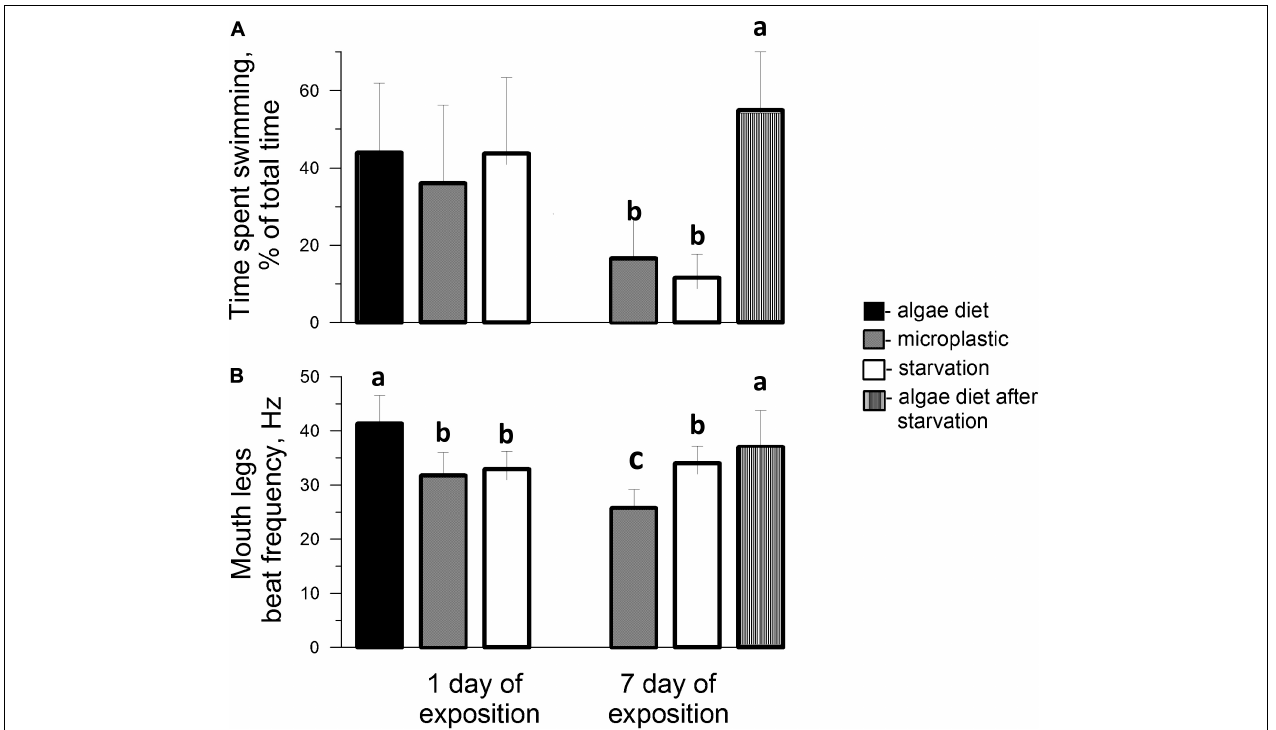
FIGURE 8 | Time spent swimming (A) and mouth appendage beat frequency (B) in adult females feeding on Rhodomonas salina ( (cid:4) ), microplastics of 6 µ m size ( (cid:4) ) and starved ( (cid:3) ) on Days 1 and 7 of experiments (Treatments RESP3 and RESP4) and adding microalgae to the aquarium with females starved 7 days (the most right bars with vertical lines). Low-case letters denote significant differences between means using Duncan’s Multiple Range test ( P < 0.05).